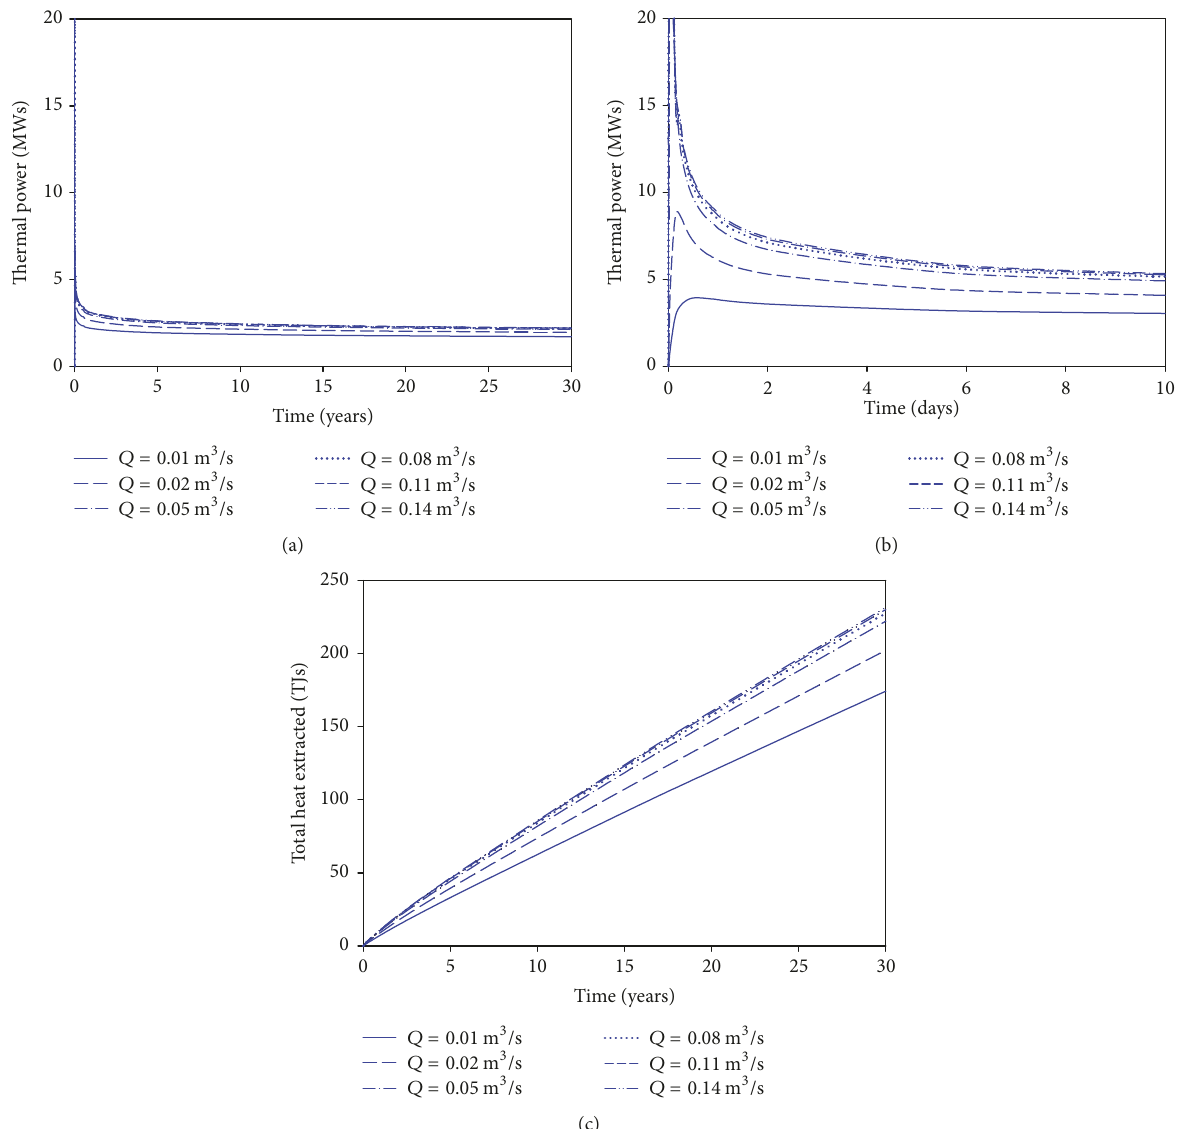
Figure 6: Thermal power and total heat extracted for different injection rates: thermal power (a) for large time and (b) for short time and (c) total heat